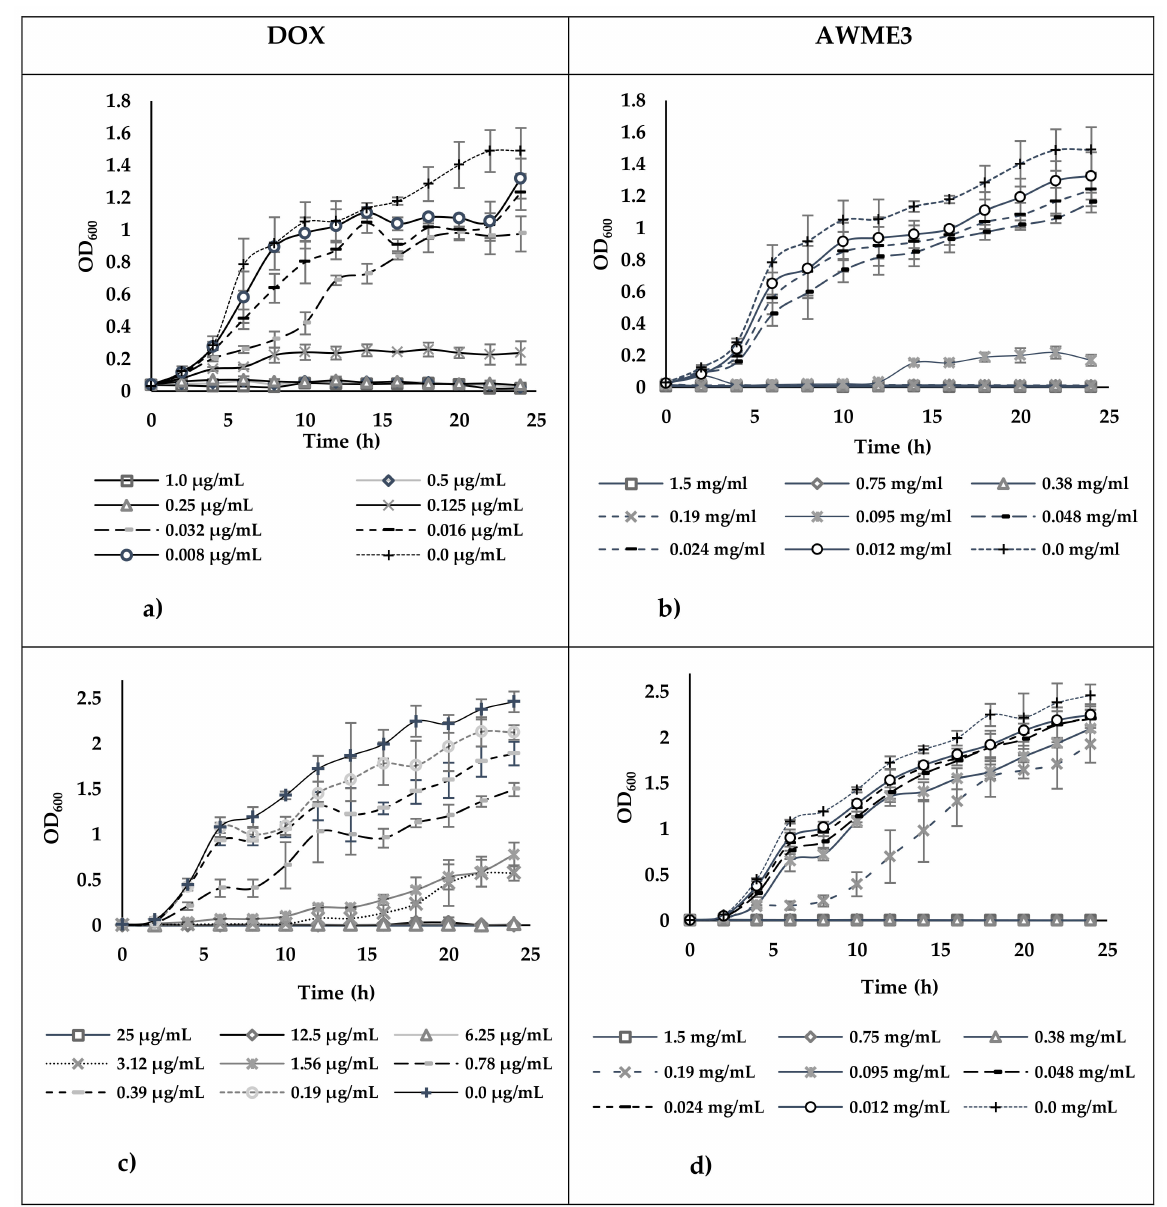
Figure 7. The growth curves of ( a , b ) A. hydrophila and ( c , d ) A. salmonicida treated with different concentrations of either AWME3, or DOX. Each data point is the average of three independent assays ± Standard deviation of the mean